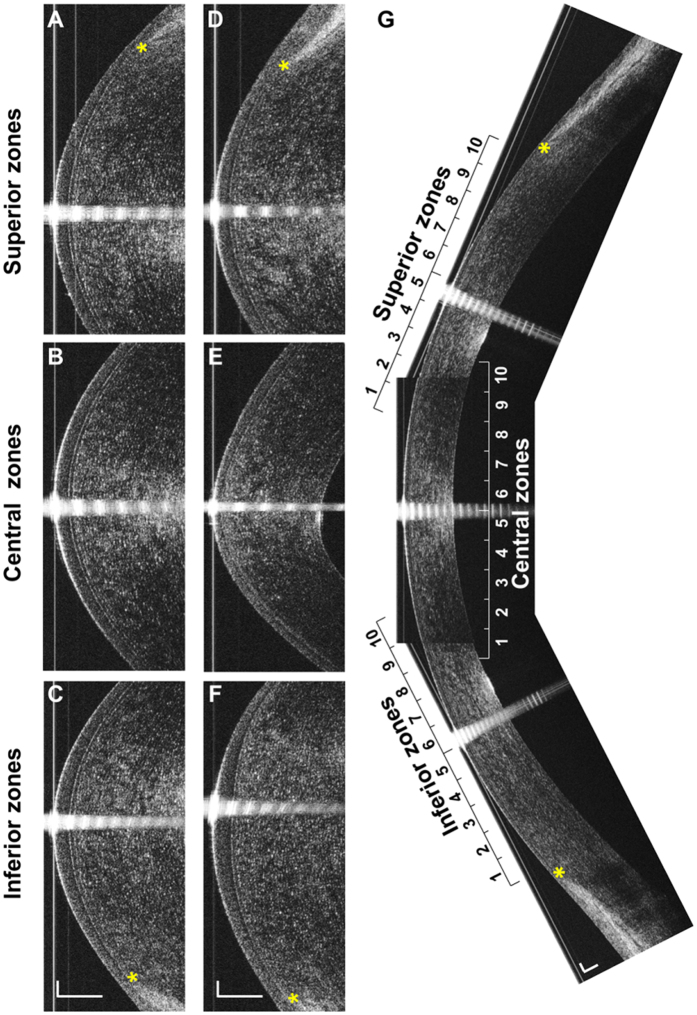
Reconstruction of the entire cornea profile.(A) Original superior corneal UHR-OCT image of a normal subject. (B) Original central corneal UHR-OCT image of a normal subject. (C) Original inferior corneal UHR-OCT image of a normal subject. (D) Original superior corneal UHR-OCT image of a KC patient. (E) Original central corneal UHR-OCT image of a KC patient. (F) Original inferior corneal UHR-OCT image of a KC patient. (G) Entire profile reconstruction of a normal cornea. For data analysis, each region was divided into 10 equal zones. The superior and inferior zones ended at the edges of Bowman’s layer. The central zones were centered on the corneal vertex. *the edge point of Bowman’s layer. Bars = 250 μm.